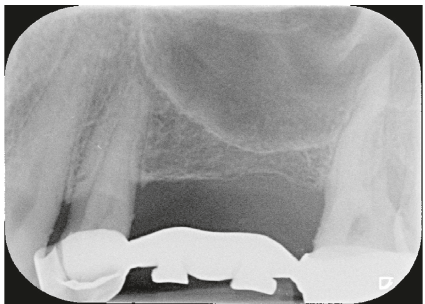
Figure 1: Maxillary left posterior PFM bridge must be replaced. Two implant-supported crowns need to be placed. In both surgical sites, reduced basal bone height is